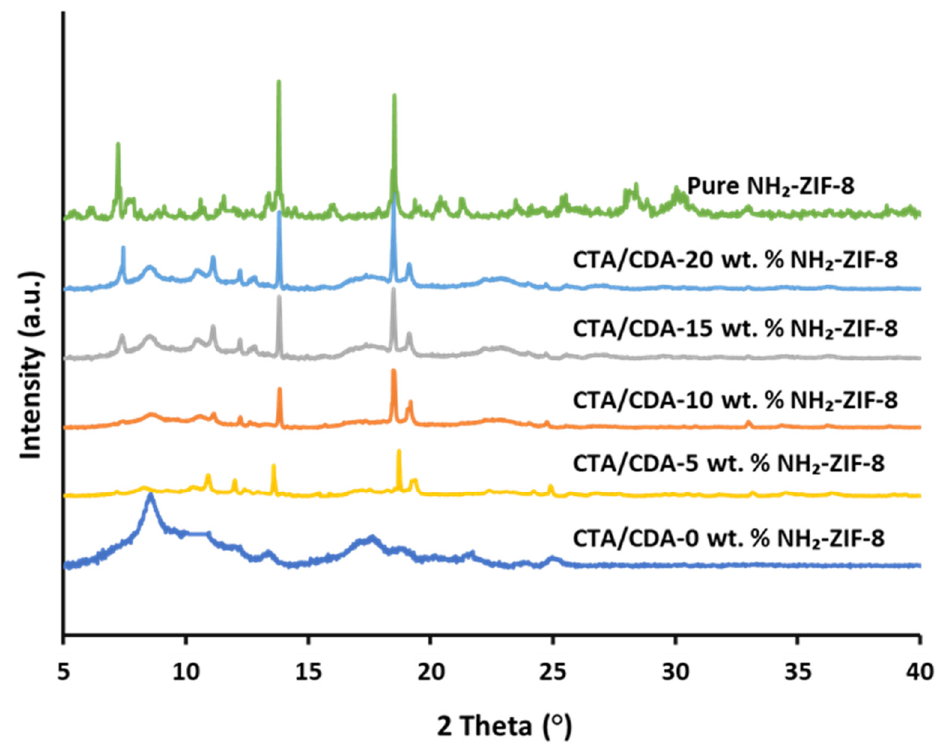
Figure 3. XRD analyses of pure NH 2 -ZIF-8 and CTA/CDA-NH 2 -ZIF-8 MMMs with different NH 2 - ZIF-8 loadings.